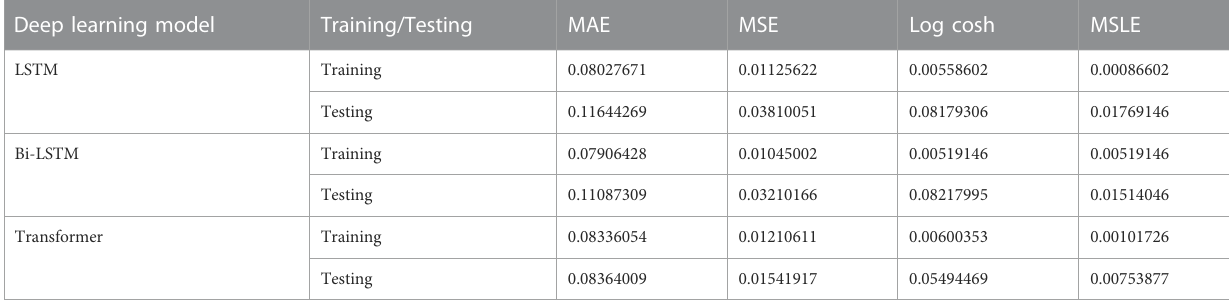
TABLE 3 Results of different models during training and testing using Japan Dataset. Deep learning